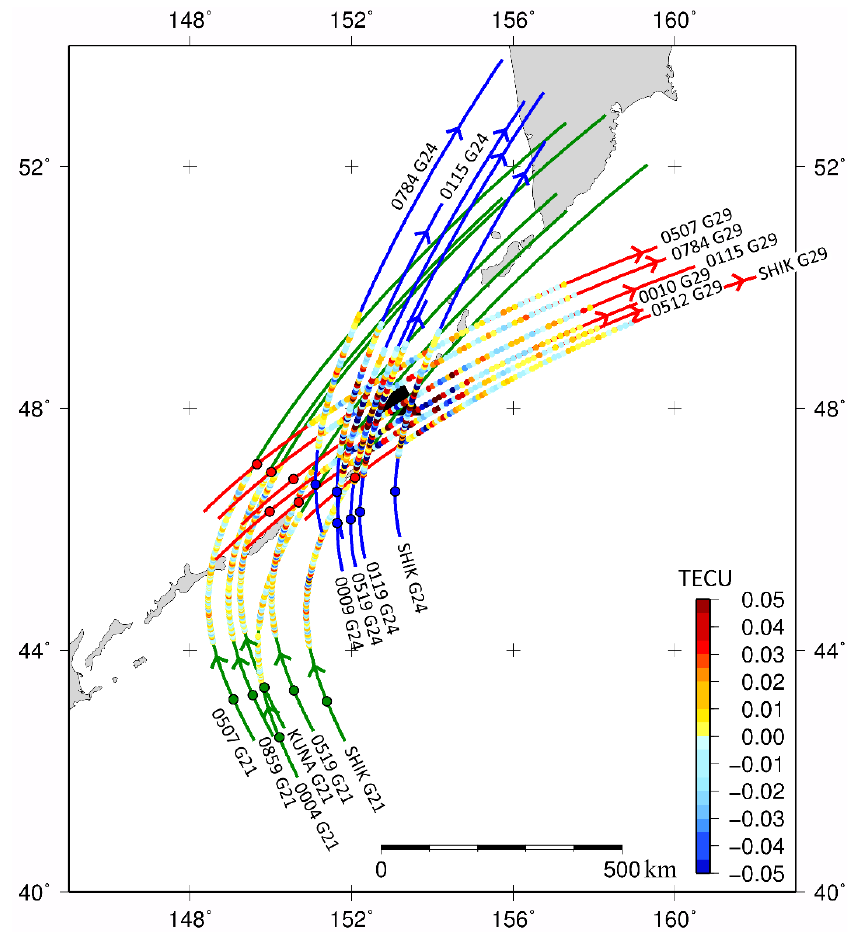
Figure 10. The map of TEC measurements performed during 09:00–13:00 UT on 15 June 2009. Color lines with arrows indicate trajectories of ionospheric piercing points (IPPs). Dots show the IPPs locations at 09:18 UT, i.e., time of the explosion. All other notations are identical to the appropriate ones adopted in Figure 2.